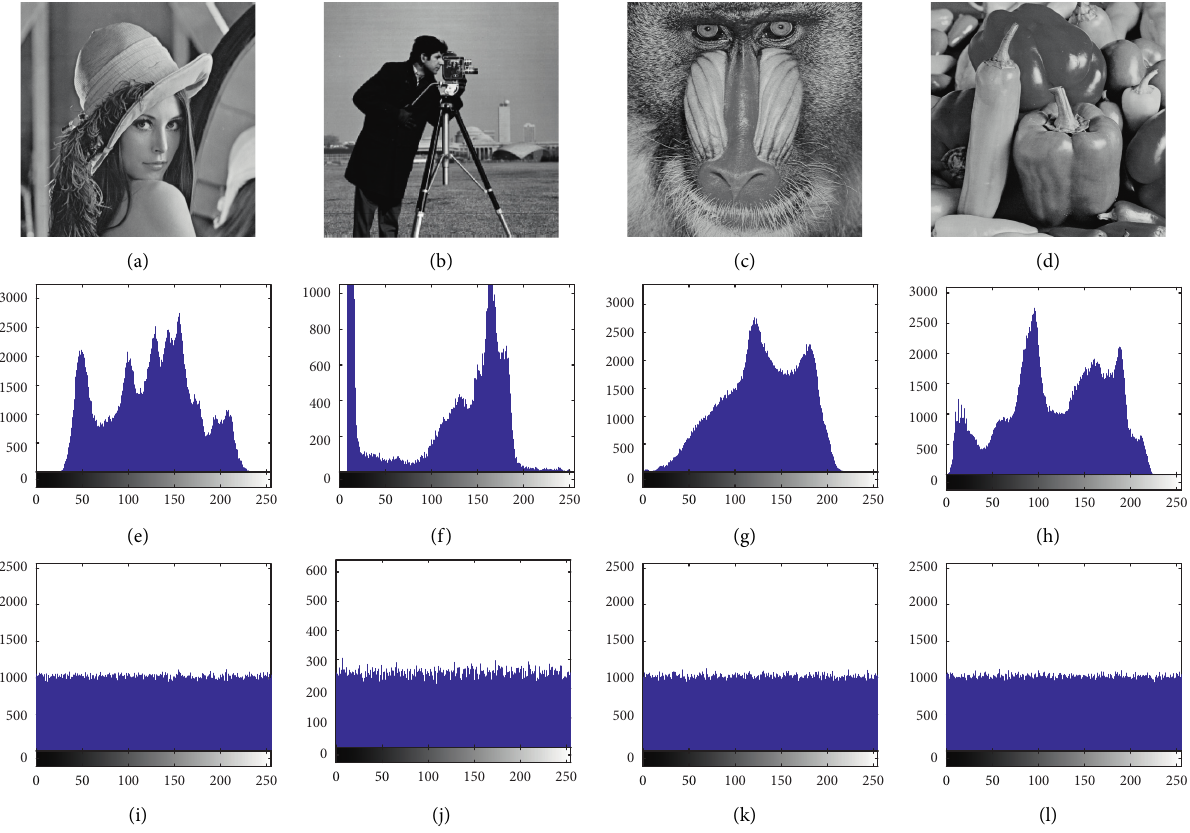
Figure 14: Simulation results of sample test images: (a) Lena, (b) Cameraman, (c) Baboon, and (d) Peppers, respectively; (e)-(h) histogram of original images; and (i)-(l) histogram of cipher